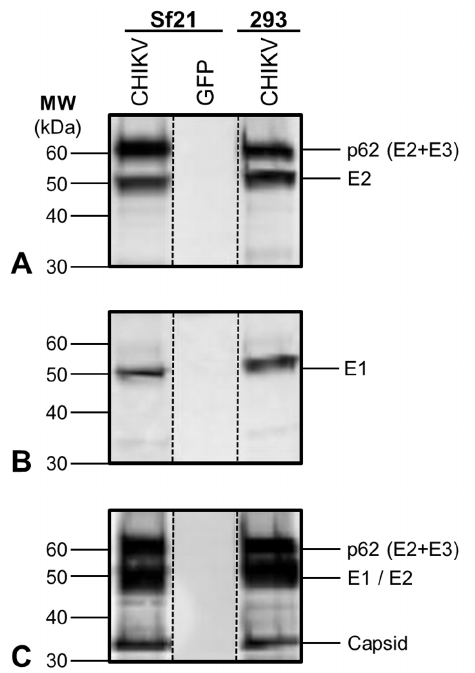
Figure 1. CHIKV structural polyprotein expression and pro- cessing in AcMNPV-CHIKV37997 infected Sf 21 cells and pV1JNS-CHIKV37997 transfected HEK293 cells. Cell lysate Western blots depicting ( A ) E2 expression and processing, detected by an E2 peptide-specific antibody. ( B ) E1 expression, detected by an E1 peptide-specific antibody. ( C ) E1/E2 (co-migrating) and capsid expres- sion and processing, detected by an anti-CHIKV polyclonal antibody. AcMNPV-GFP infected Sf 21 lysate was included as a negative control for insect cells and baculovirus vector.